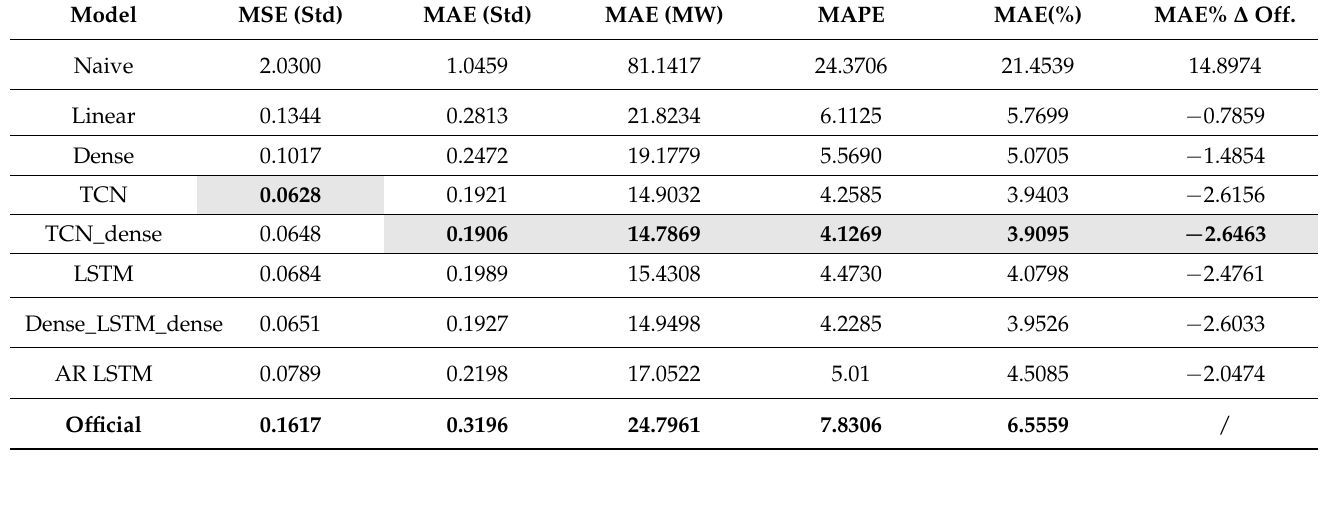
Table 4. Performance of models for electricity load prediction in comparison to the official prediction.